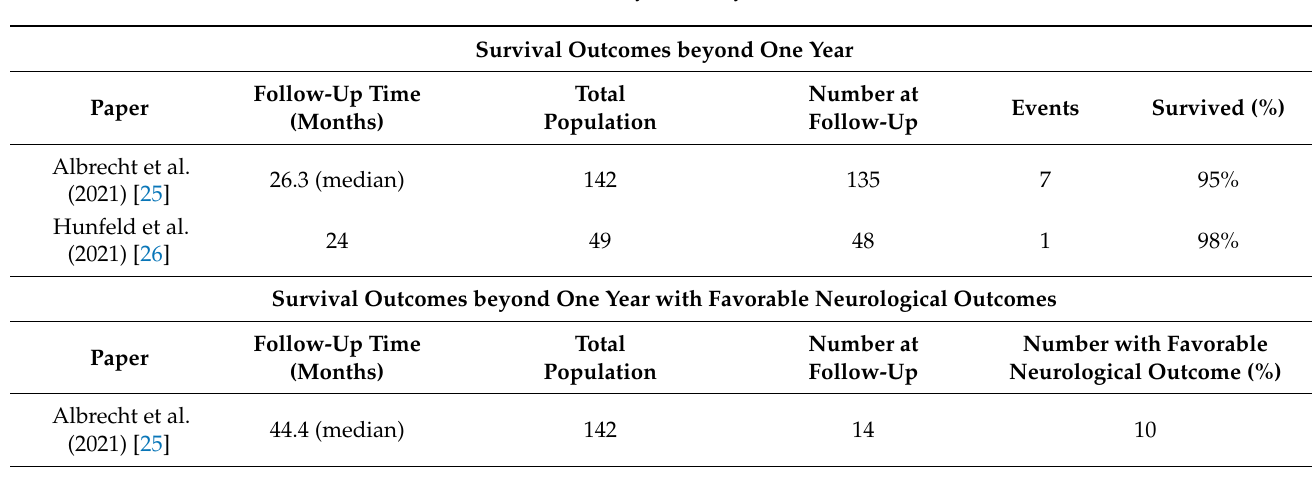
Table 1. Survival outcomes beyond one year.